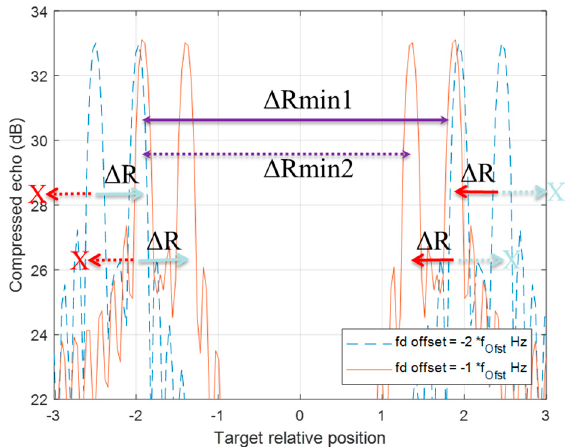
Figure 15. Two moving target MDSC of Figure 7 Case 3. The signal is traced by minus two f d _o ff set Hz DSC (blue-dotted line) and minus one f d _o ff set Hz DSC (red line). Since the target 1 pair is always enclosed by target 2 in such scenarios, the grouping rule always pairs the target 2 left detection with target 1 right detection at each